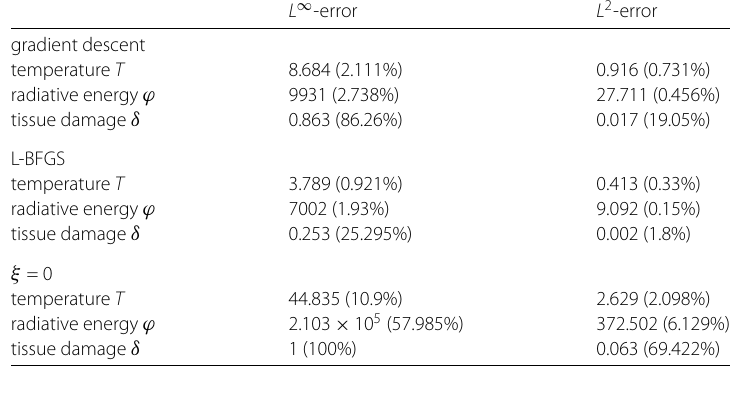
Table 2 Comparison between the simulated and measured temperature for a single measurement